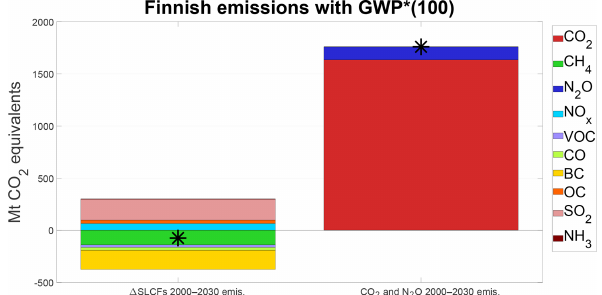
Figure 3. The CO 2 -equivalent emissions for the period 2000–2030 given the alternative metric GWP ∗ ( 100 ) . The net impact of SLCFs (left) and CO 2 and N 2 O (right) is given by the